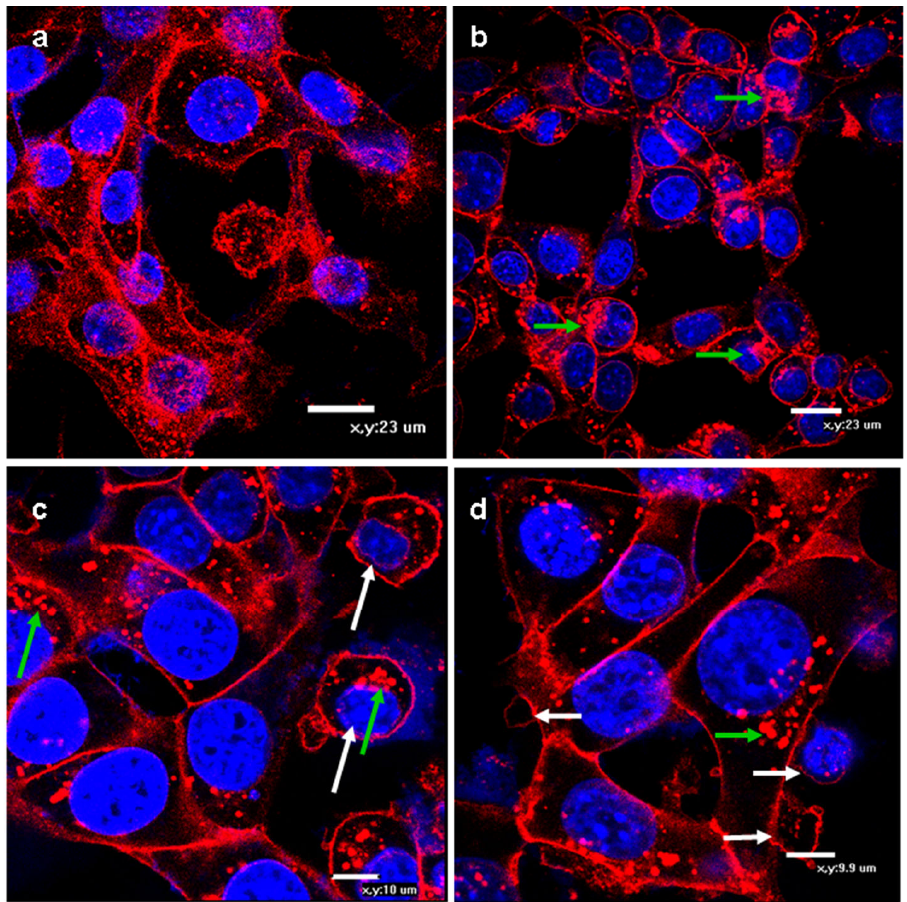
Figure 9. Confocal microphotographs of control ( a ) and the compound 7c treated (5 μ M) ( b – d ) for 24 h MCF7 cells stained with Hoechst33342 (blue) and WGA-AlexaFluor555 (red). Enlargement of organelles (green arrows) and autophagolysosome formation (white arrows) are found. Scale bar is 10–23 μ m.